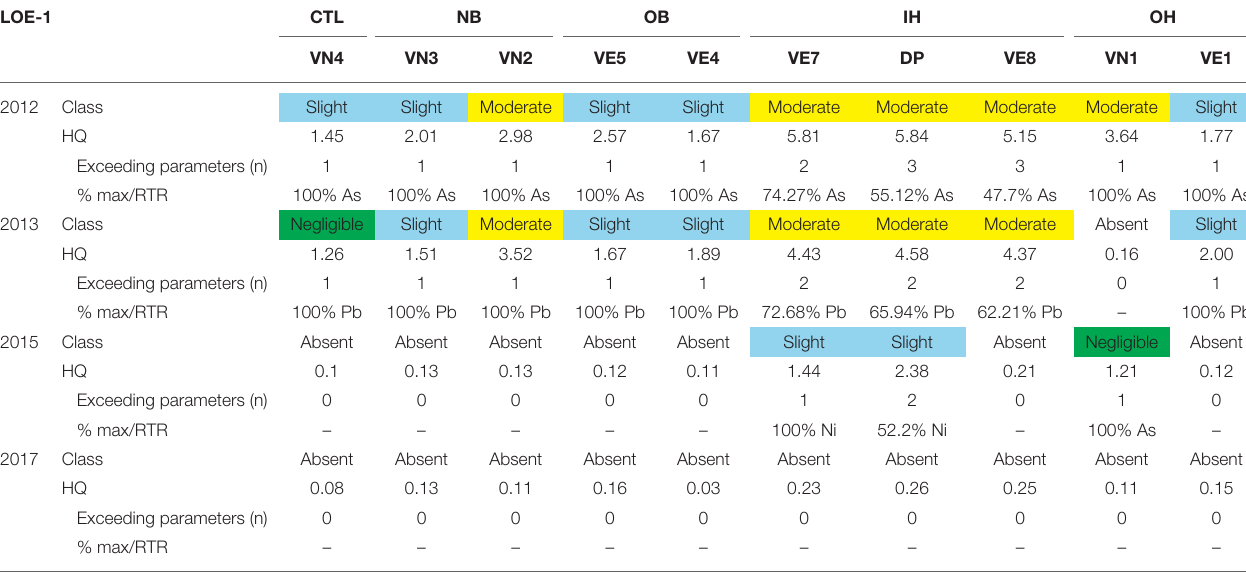
TABLE 1 | Results of the weighted elaboration of sediments chemistry, LOE-1.